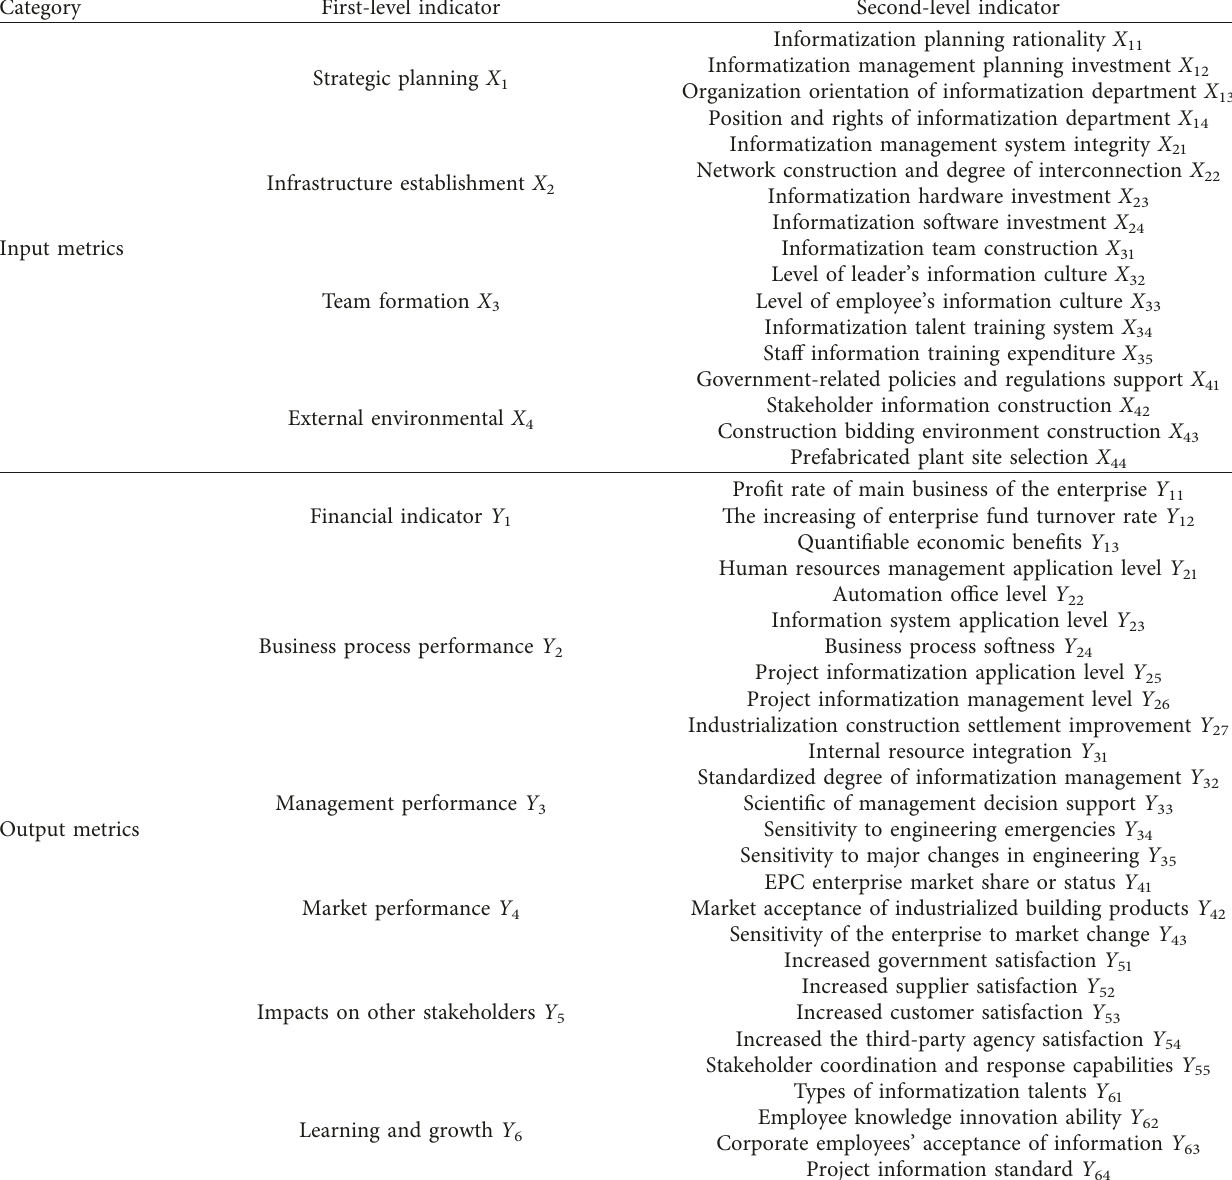
Table 1: Performance evaluation index system of construction industrialization